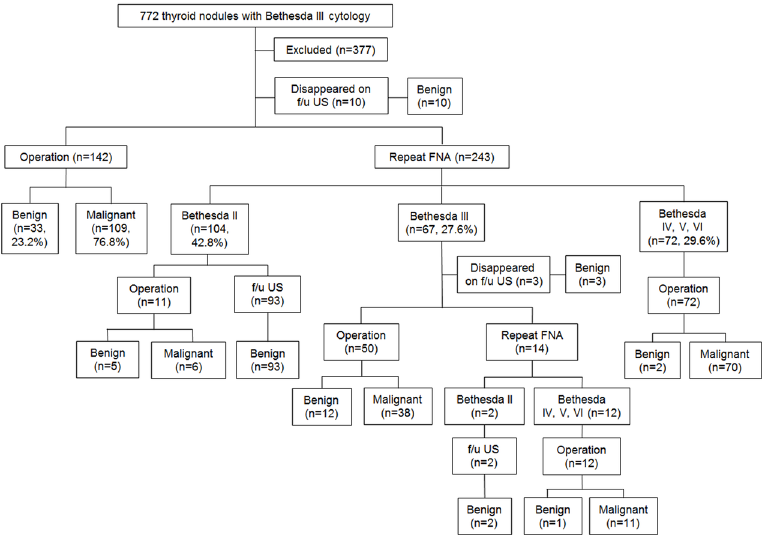
Fig 1. Diagnostic outcomes of 772 thyroid nodules with Bethesda category III cytology. f/u, follow-up; US, ultrasound; FNA, fine needle aspiration.